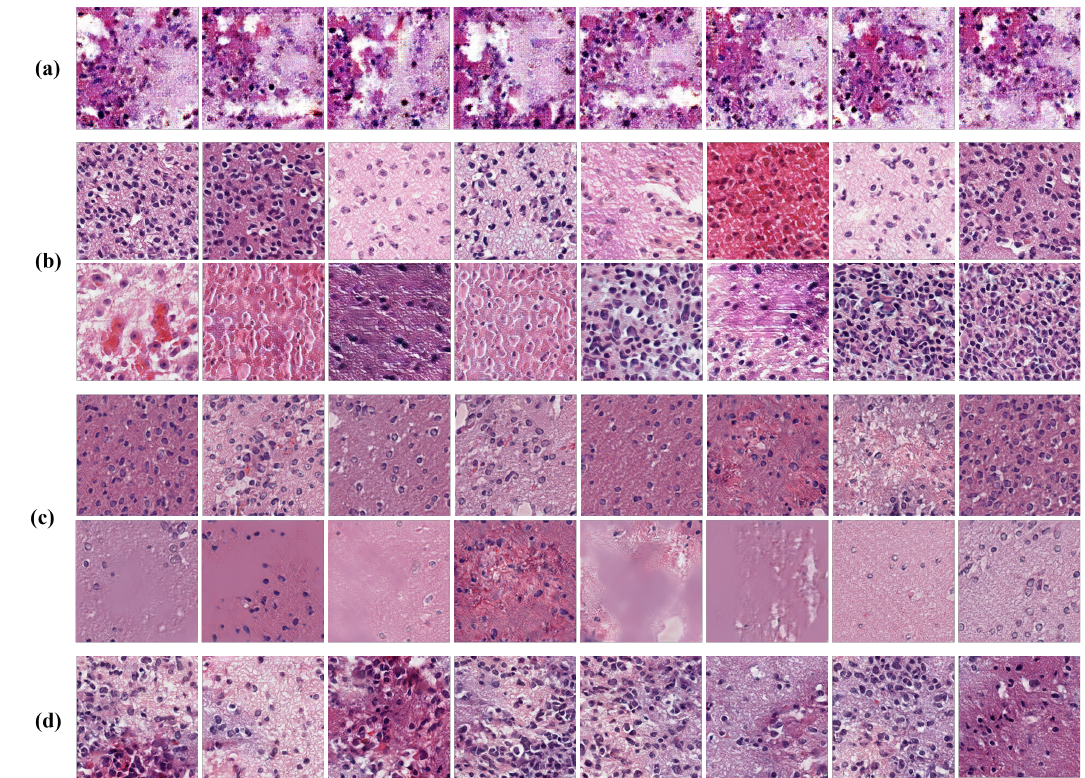
Figure 9. Generated samples from the WGAN-GP, PGGAN, Boyd et al. and our model. ( a ) The WGAN-GP samples generate images with a poorly uniform staining color and quality. ( b ) The PGGAN samples contain unrealistic patterns that do not exist in real data. ( c ) The samples from Boyd et al. generate images with high quality (upper row) but sometimes fail to generate (lower row). ( d ) The samples from our model generate images with a poorly uniform staining